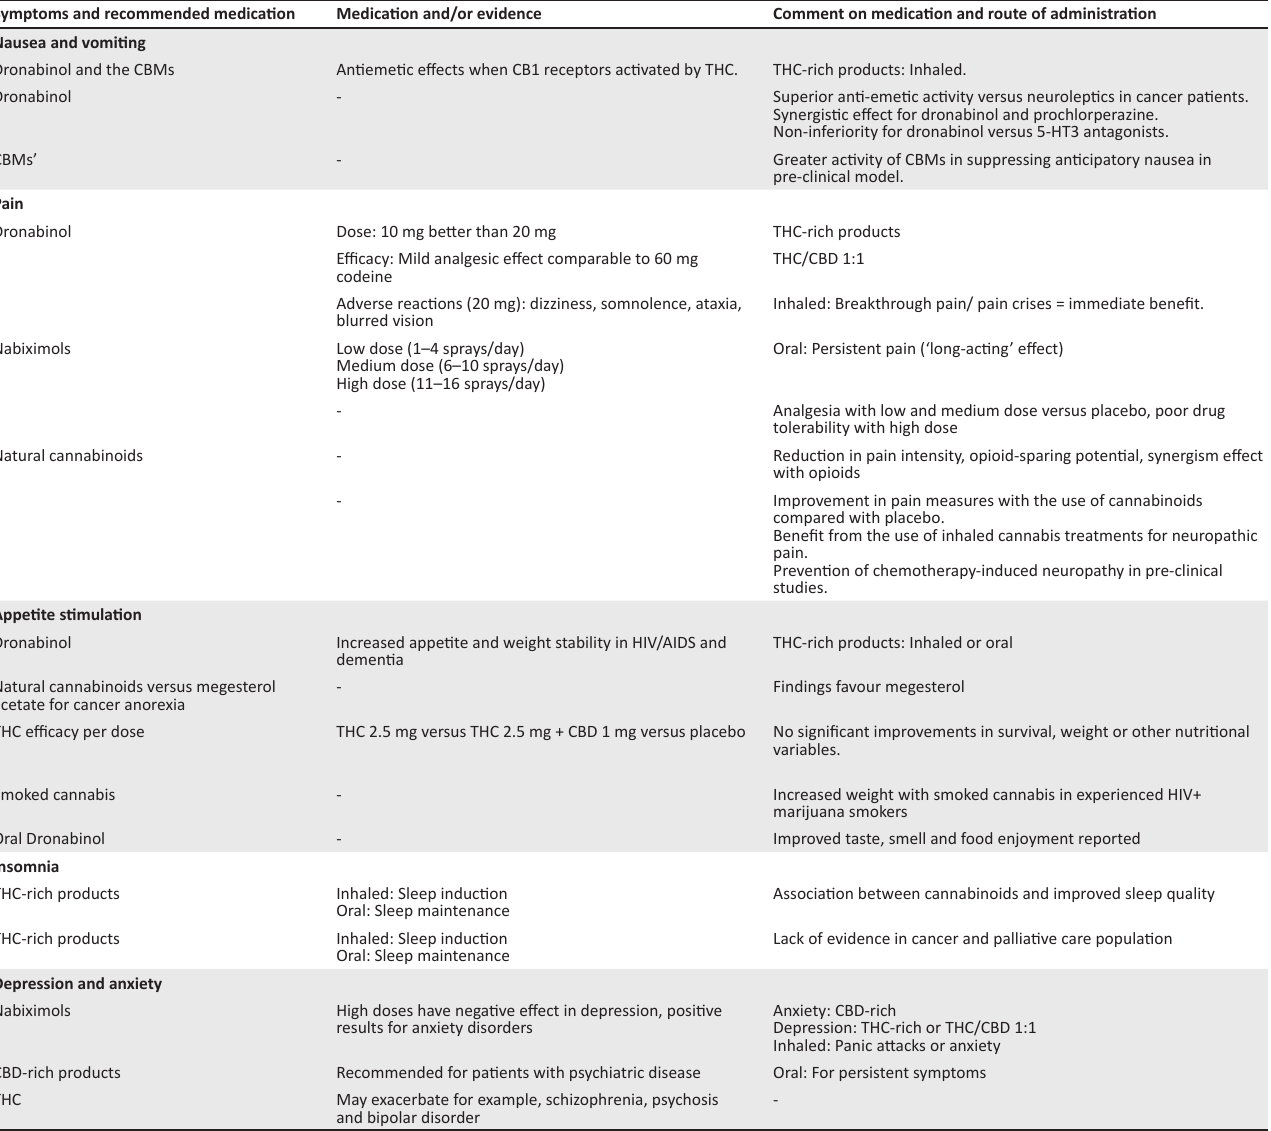
TABLE 5: Recommendations for cannabinoid use in symptom management of HIV/palliative care. 72 Symptoms and recommended